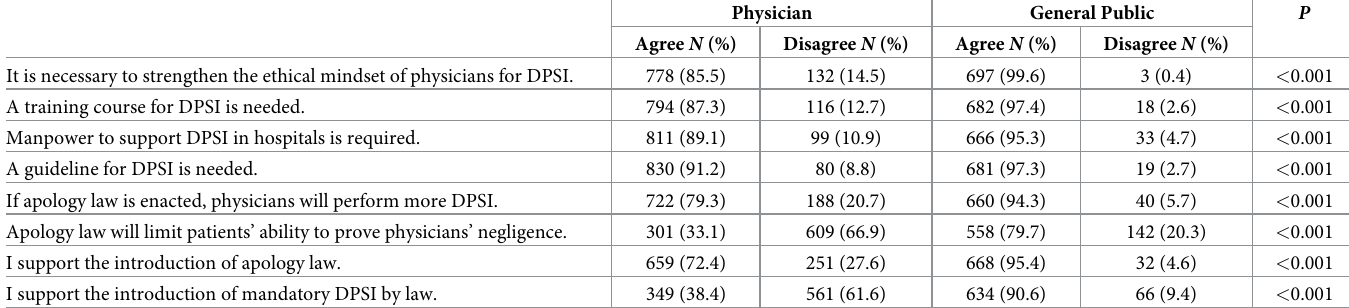
Table 6. Opinions on methods for facilitating